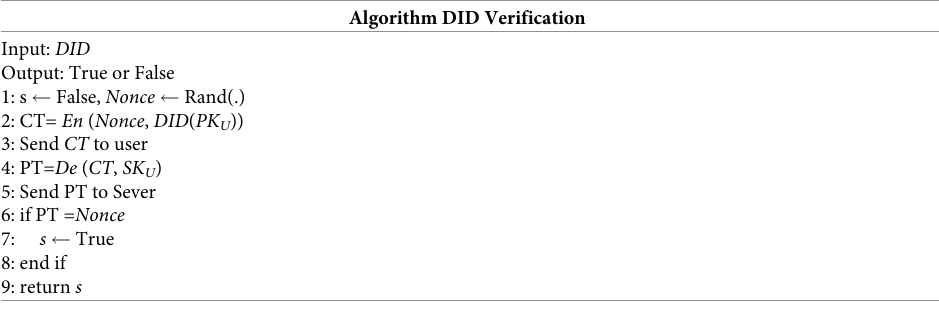
Table 4. Algorithm DID